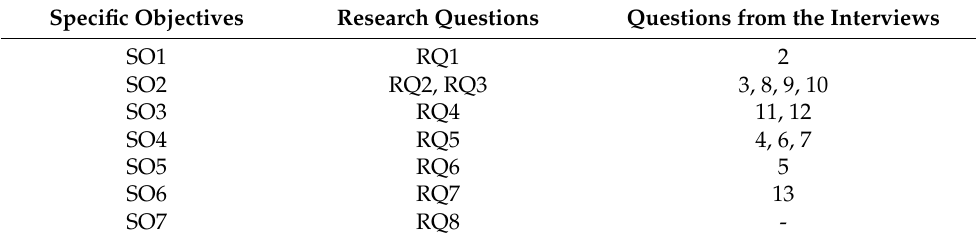
Table 6. Relationship of specific objectives to interview questions. Specific